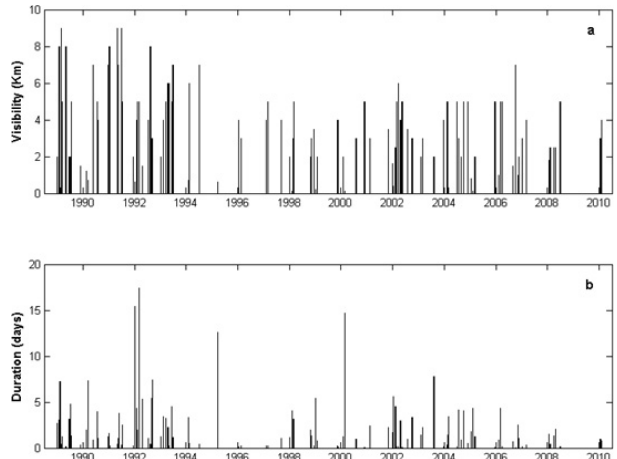
Fig. 4. Visibility (km) (a) and duration (days) (b) of dust events (HZ, DU, DRDU or DS) over the Canaries for the period 1989– 2010